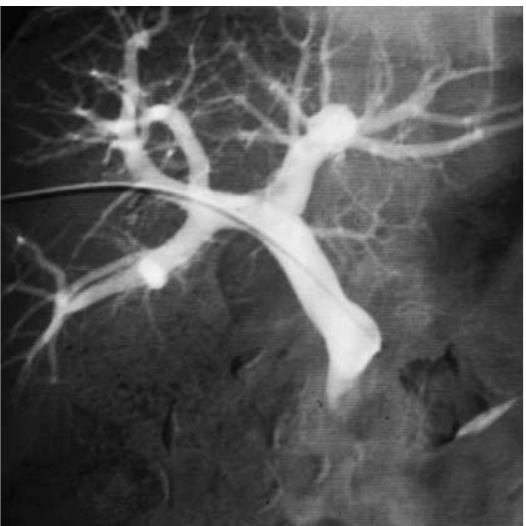
Transhepatic portal venogram. The cathe- ter has been placed in the main portal vein prior to injection of